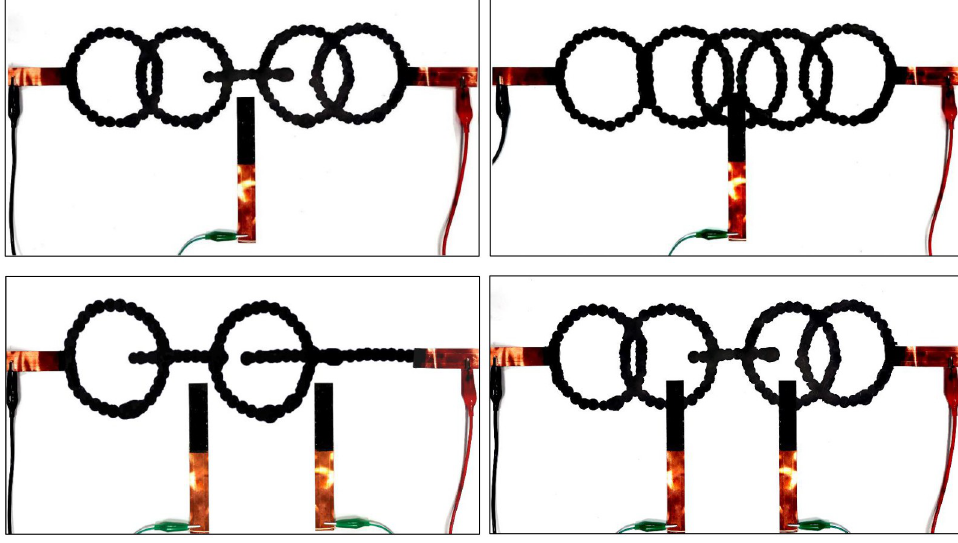
Fig 9. Examples of circuit patterns drawn during optimization. The left patterns avoid obstacles and achieve high load voltage. The right ones touch the obstacles and thus show a low voltage although they have more circles.